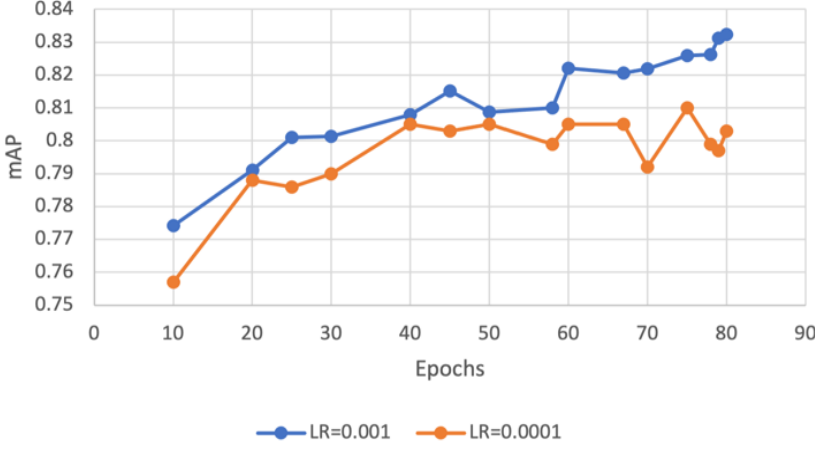
Figure 7. The mAP of the Mask R-CNN model at different